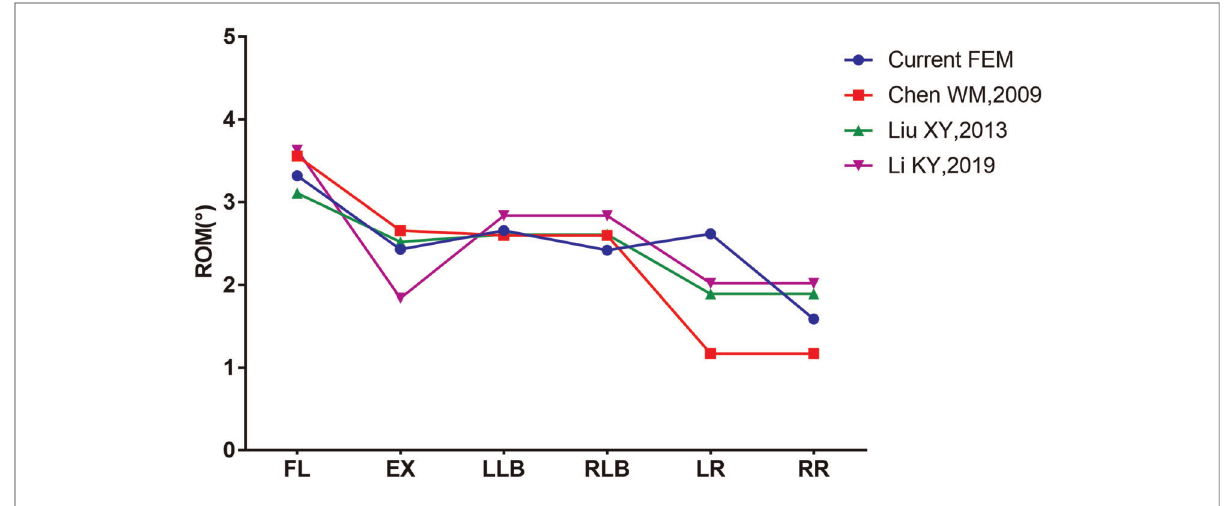
FIGURE 4 Range of motion of the model compared with literature reports.